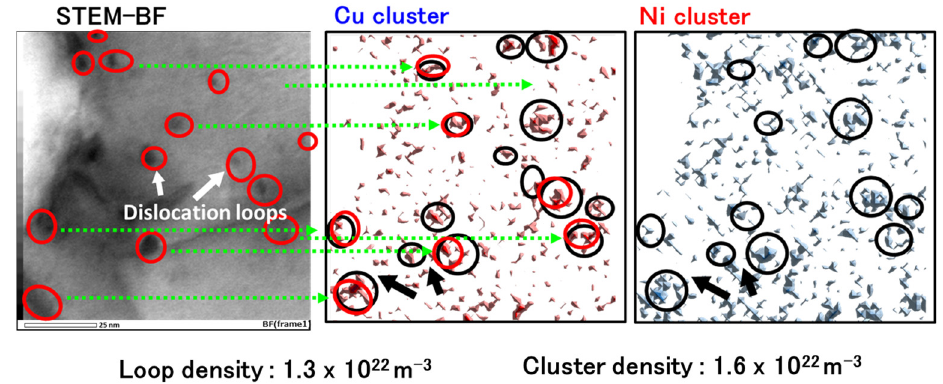
Figure 8. Co-segregation of Cu and Ni atoms formed in A533B and irradiated at 290 °C at a dose of 4.1 × 10 24 n/m 2 . Cu cluster (red circles), Ni cluster (black circles).